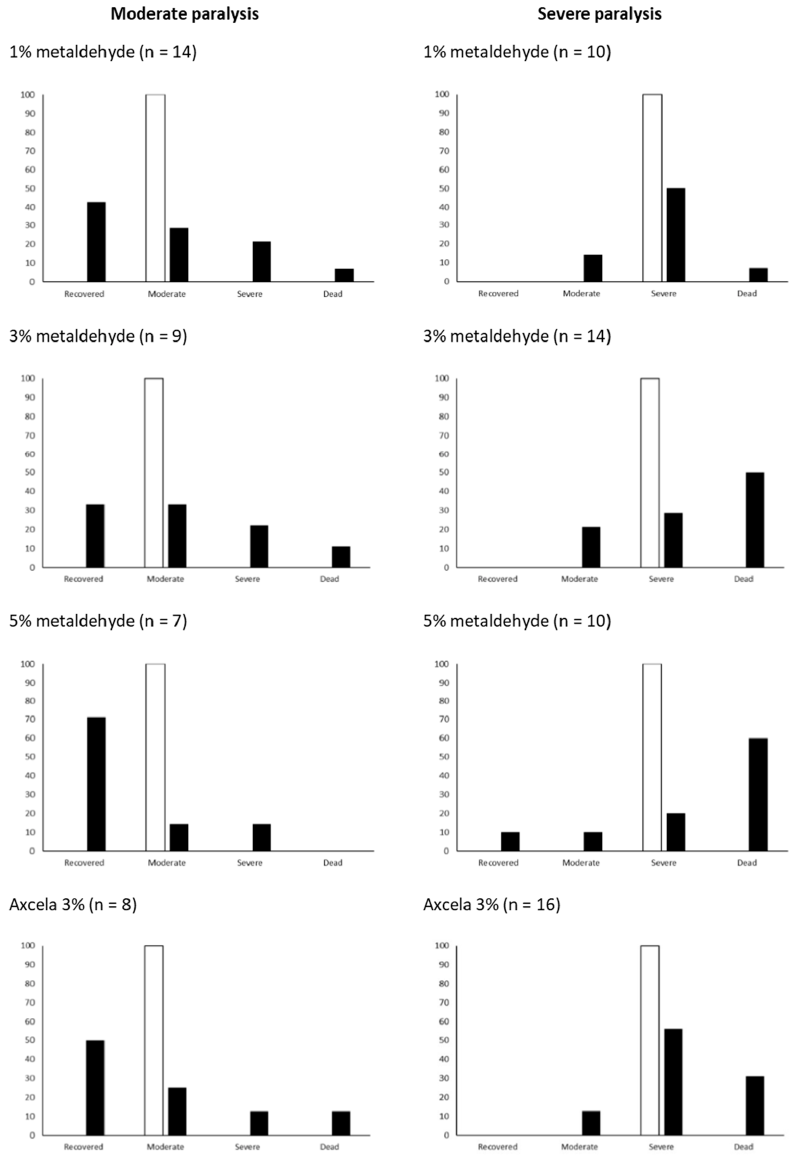
Figure 3. The outcomes of moderate or severe poisoning with metaldehyde baits. Baits were experimental with 1%, 3% or 5% metaldehyde or commercial Axcela (3%) pellets. Slugs were assessed at 14 h after the start of exposure (white bars). The percentage of poisoned slugs that were assessed in the same or different category are shown at 72 h as black bars. The numbers of slugs in each cohort (indicated above each figure) have been converted to percentages for comparison purposes.